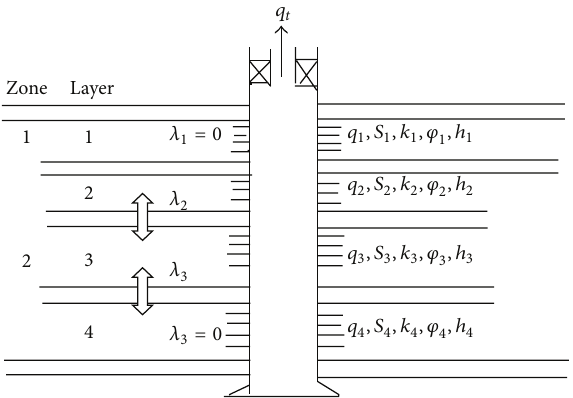
Figure 1: Sketch of a multilayer